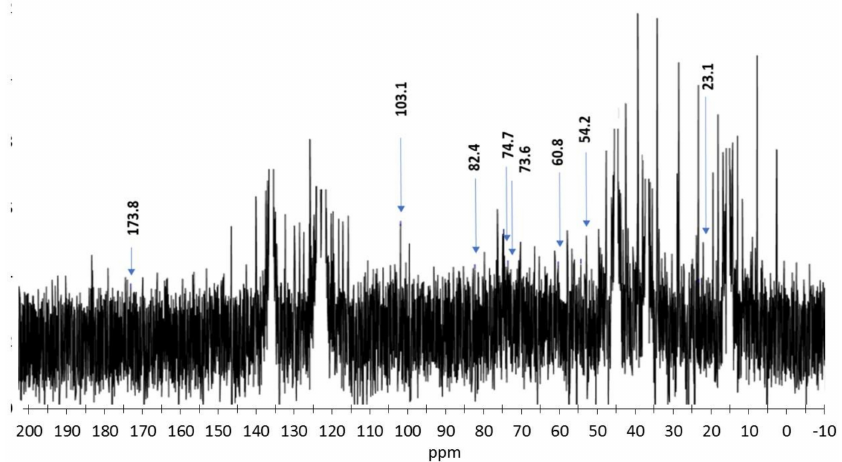
Figure 4. 13 C NMR spectrum. Chitosan chemical shifts stand